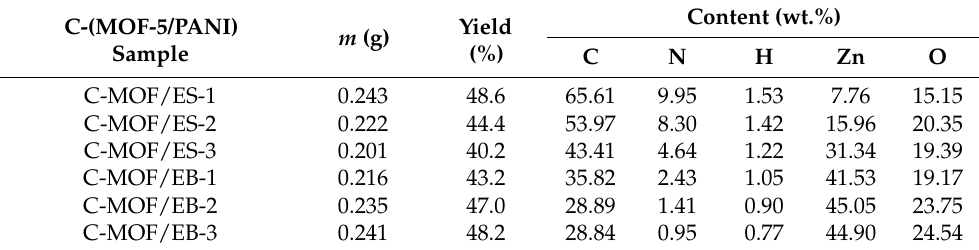
Table 1. Mass (m), the carbonization yield (calculated for 0.5 g of MOF-5/PANI precursor), and the bulk elemental composition of the as-prepared C-(MOF-5/PANI) samples determined by elemental microanalysis (C, H, and N), FAAS (Zn), and by difference (O). C-(MOF-5/PANI) m (g) Sample